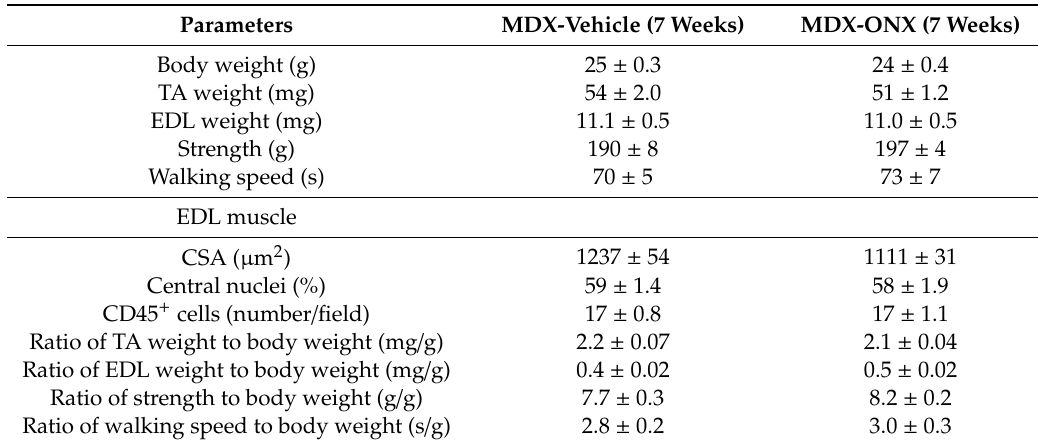
Table 3. ONX-0914 treatment for a period of 9 days in MDX